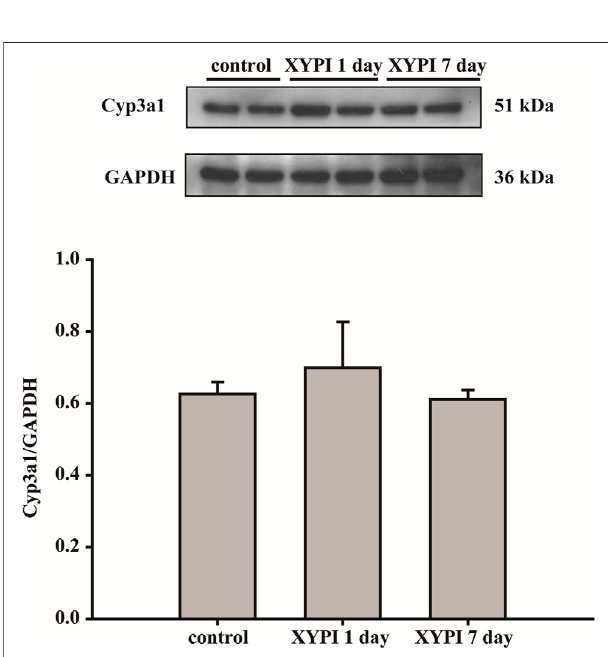
FIGURE 3 | Effects of XYPI on Cyp3a1 protein expression in rat